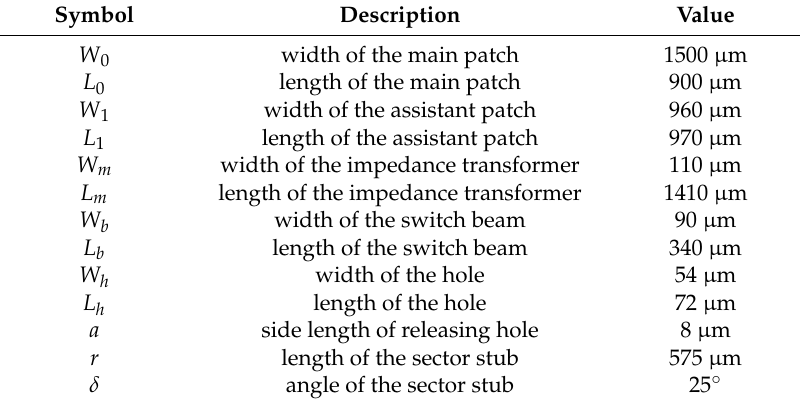
Table 1. Optimized configurations of the antenna and